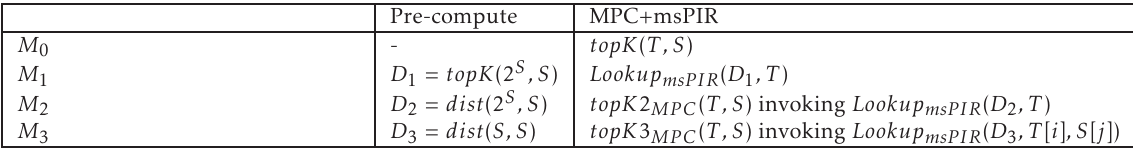
Table 4. Partitioning topK algorithm to the precomputation-MPC framework: For notation in this table, T , S are true and all producers as in the topK () algorithm in List 1. D for i = 1 , 2 , 3 are the table storing precomputation results. MPC is secure i multi-party computation protocol and msPIR is a special MPC protocol for multi-server private information retrieval.